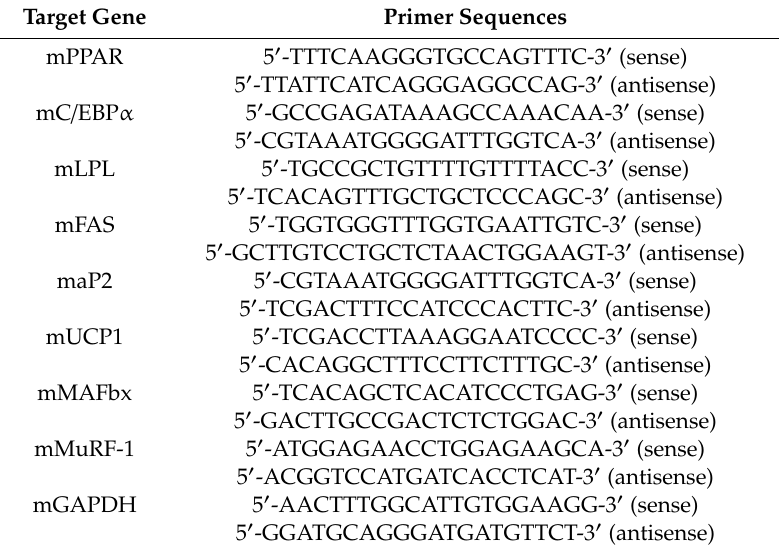
Table 1. Primer sequences for real-time RT-PCR. Target